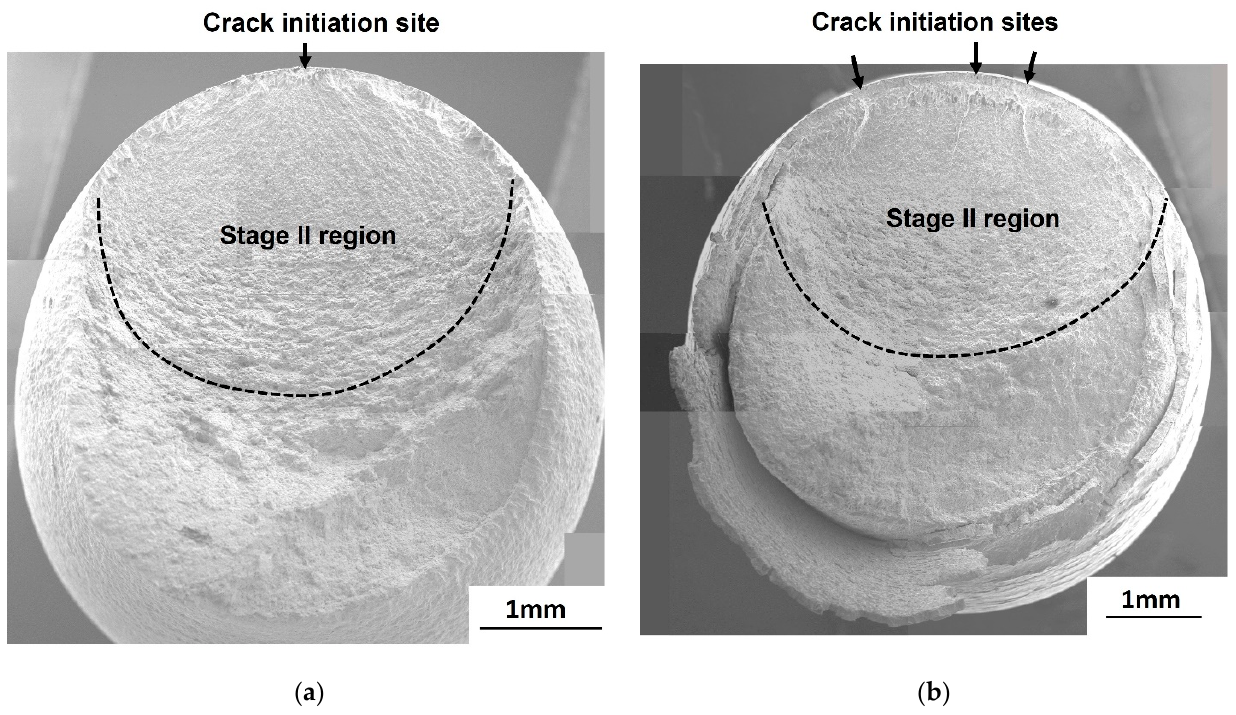
Figure 7. Fatigue fracture surfaces of normalized AISI 1020 steel in the high cycle fatigue at R = 0.01: ( a ) non-galvanized, σ max = 339.6 MPa and ( b ) galvanized, σ max = 319.5 MPa.